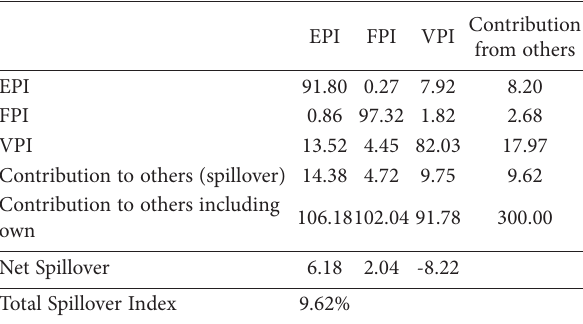
Table 5. Diebold-Yilmaz Generalized Directional Spillover